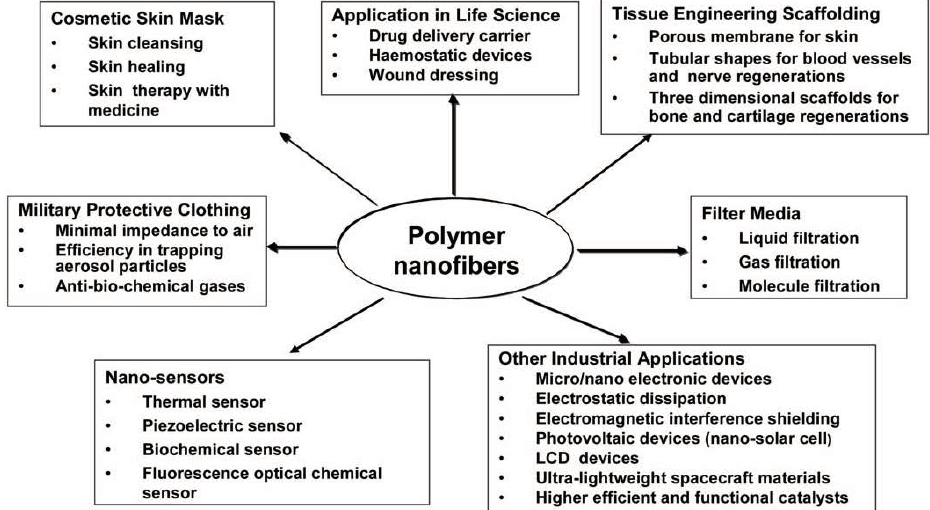
Figure 5. Potential applications of polymer nanofibers. Reprinted with permission from Elsevier, 2003